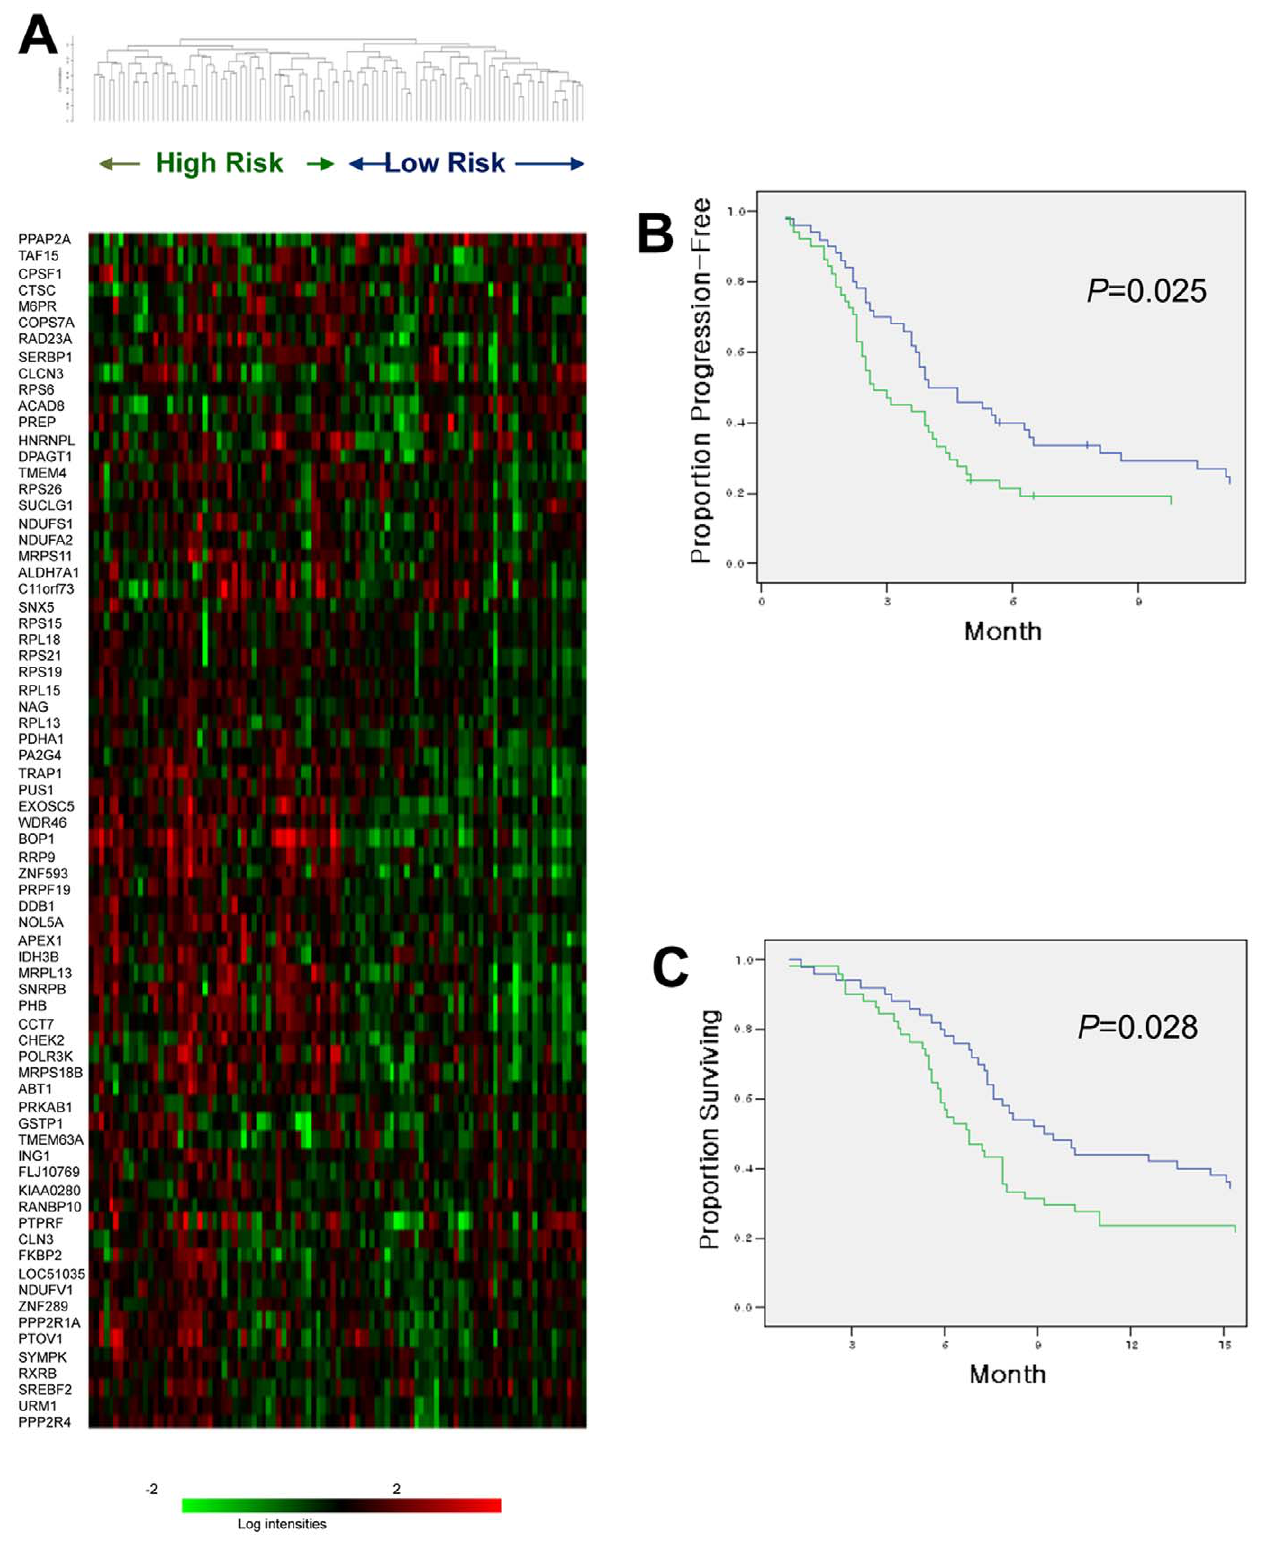
Figure 3. Hierarchical clustering analyses of pretreatment samples using the 72 genes. (A) Hierarchical clustering of the 101 gastric cancer samples using the 72 genes that are upregulated at chemoresistant state ( P , 0.01) and belong to ‘‘ES cell-related gene sets’’. (B) Patients in high risk cluster according to (A) (n=51, high expression of 72 genes) had a significantly shorter time to progression (TTP) than patients in low risk cluster (n=50, low expression) (2.7 vs. 4.0 months; P =0.025). (C) Patients in high risk cluster according to (A) (n=51, high expression of 72 genes) had a significantly shorter survival than patients in low risk cluster (n=50, low expression) (6.8 vs. 9.2 months; P =0.028).